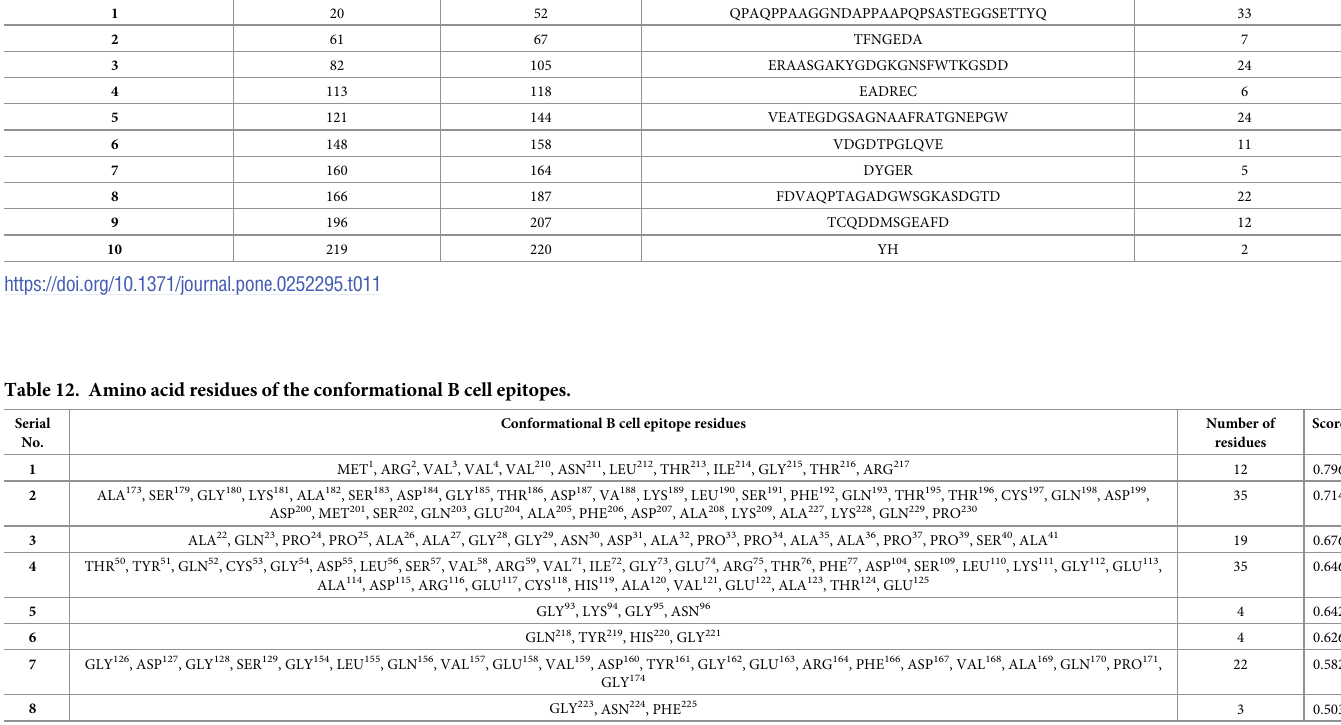
Table 11. Bepipred linear epitope prediction result. SerialNo.